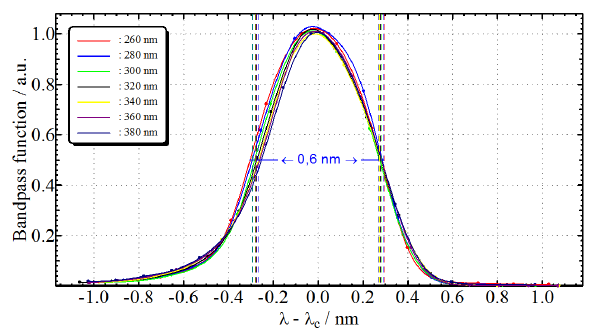
Figure 2. Bandpass function around centroid λ c for different wave- lengths with bandwidth (FWHM, dashed lines) indicated.